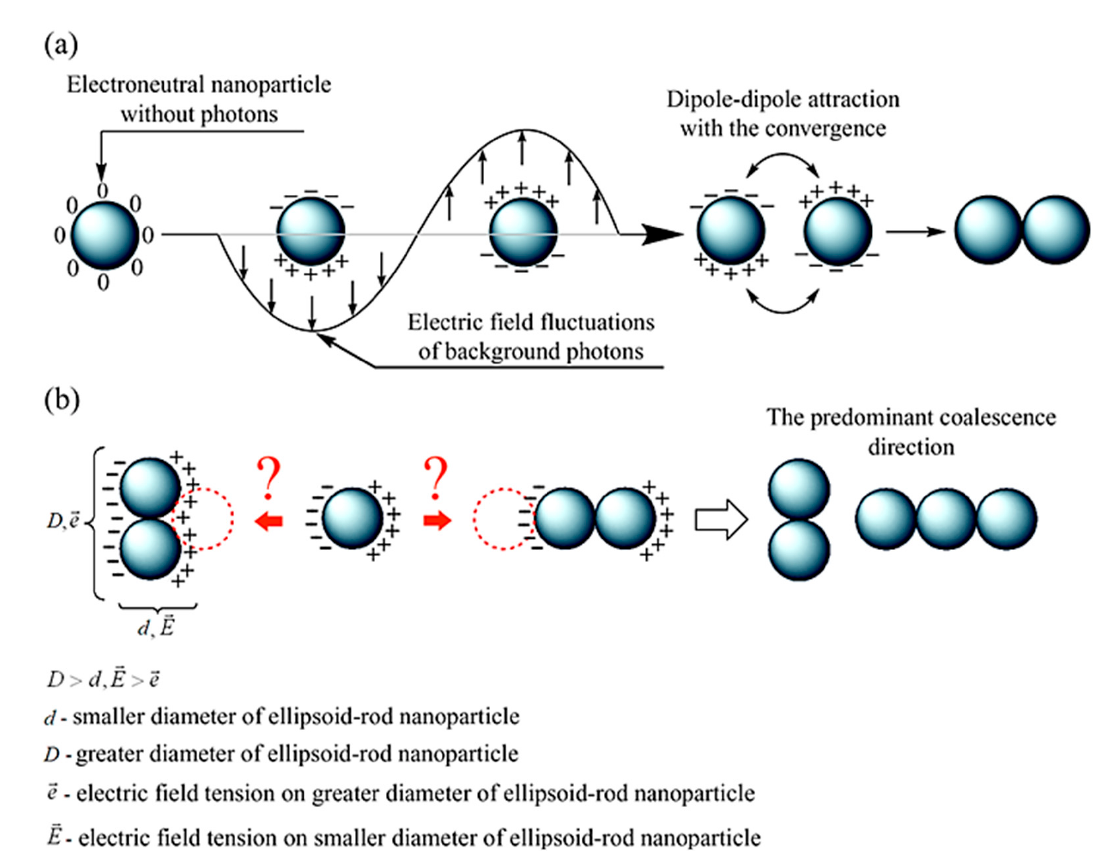
Figure 11. Plasmon–polariton stimulation of ( a ) nanoparticles drift toward each other; ( b ) predominant elongation of novel nanoparticles on the smallest geometrical poles, having the highest electric tension; the latter causes the most intense drift of primary spherical nanoparticles toward each other.